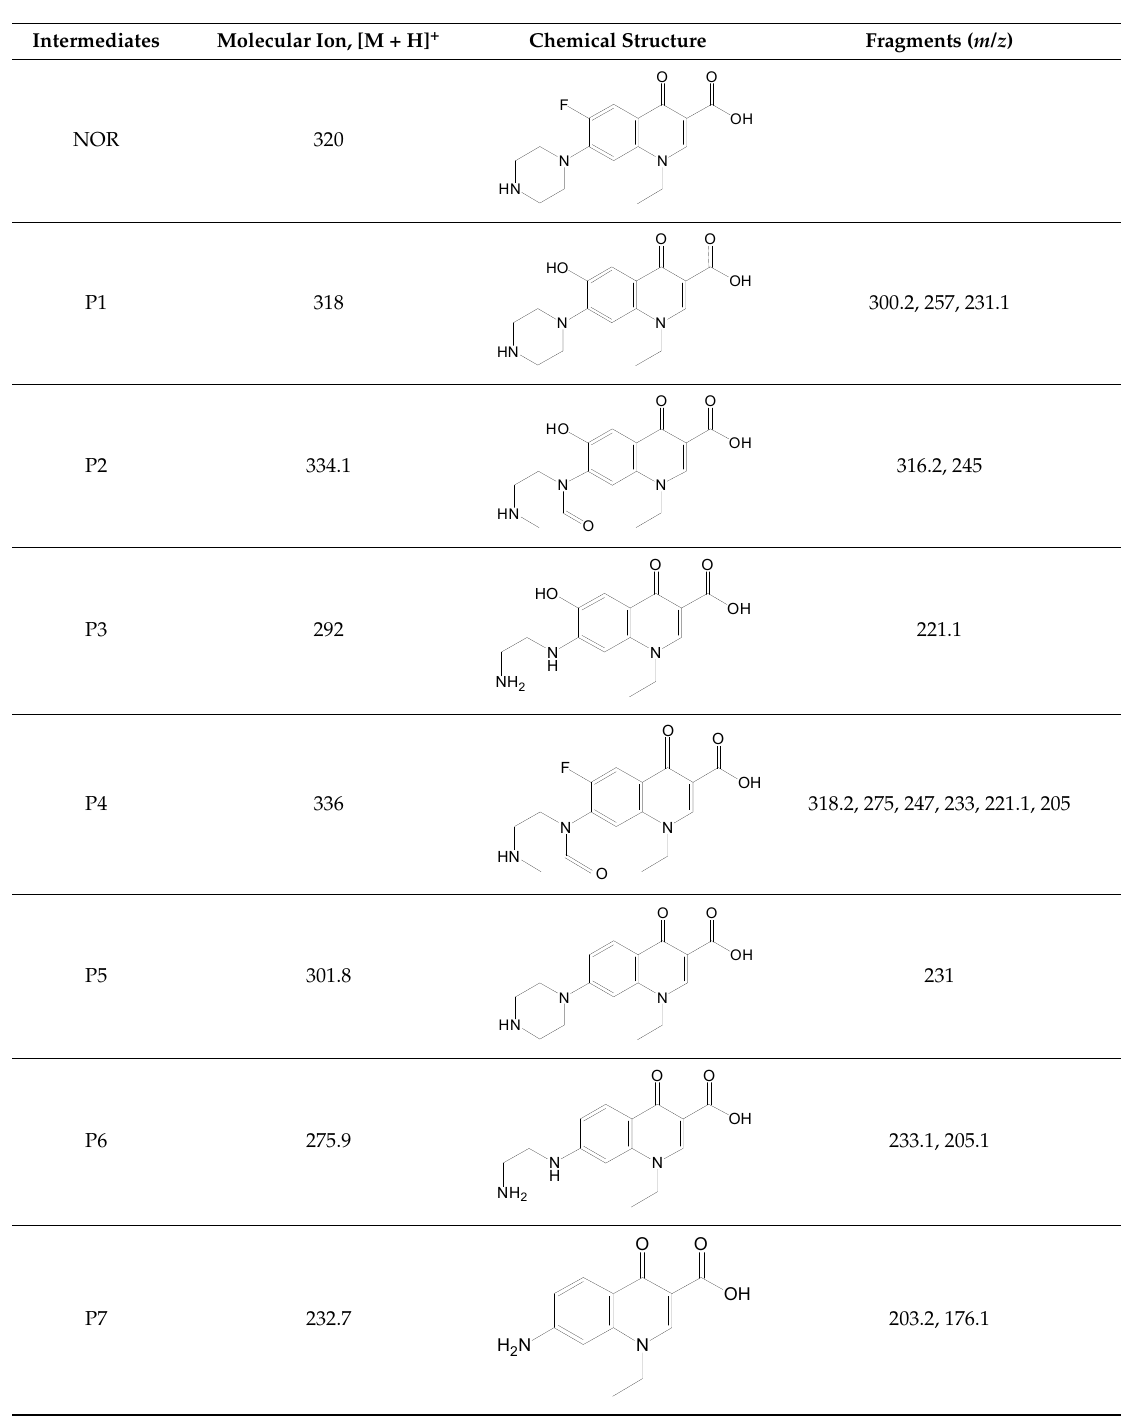
Figure 6. Degradation of NOR by the MW/UV process using different scavenging agents. (Experimental conditions: microwave power = 500 W, UV light intensity = 31.8 mW/cm 2 , maximum wavelength = 254 nm, [NOR] = 5 mg/L, [CH 3 OH] = 5 mg/L, [NaN 3 ] = 5 mg/L).